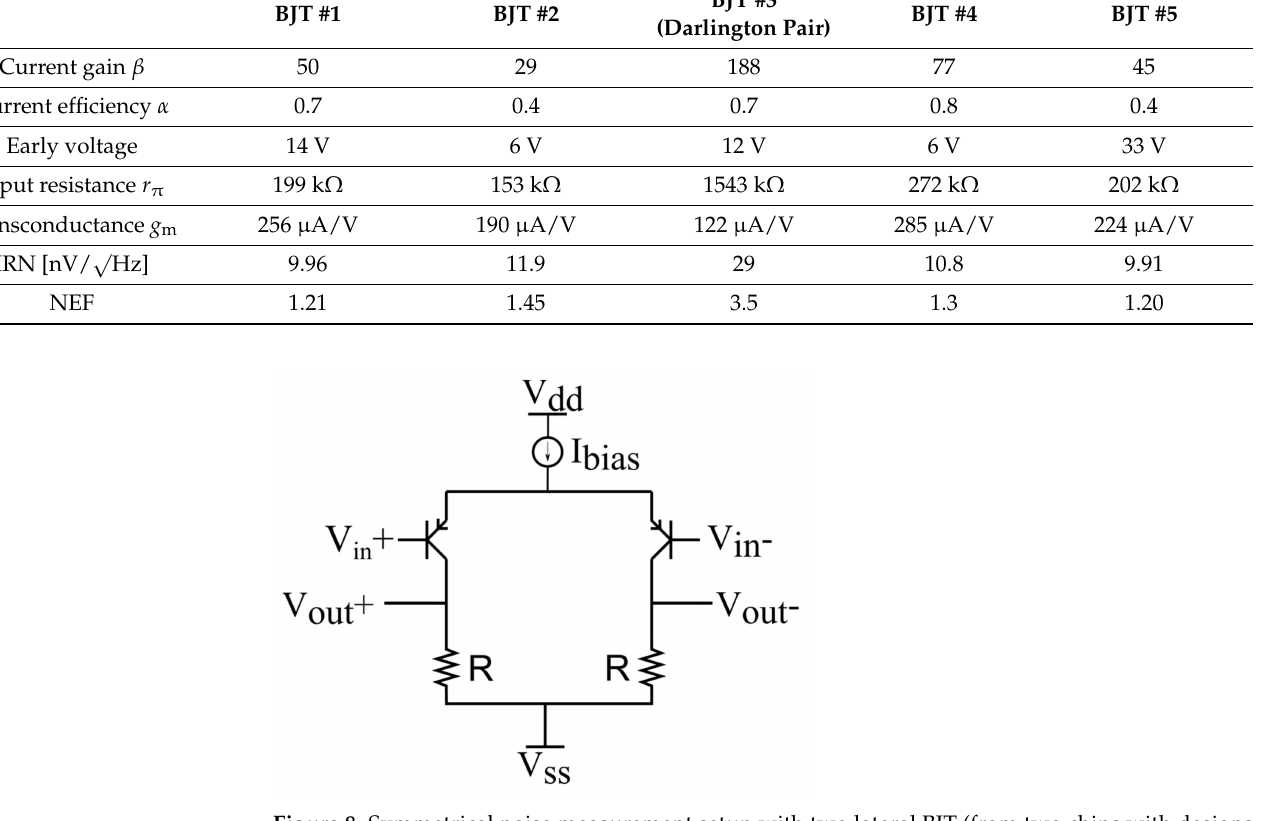
Figure 8. Symmetrical noise measurement setup with two lateral BJT (from two chips with designs as in Figure 5) with resistive loads of 100 k Ω and a bias current I bias of 20 µ A. Assuming ideal BJT transistors yields for the input-referred spot noise density of each input transistor (cid:115) 4 q · U 2 TH V n _ in = I bias